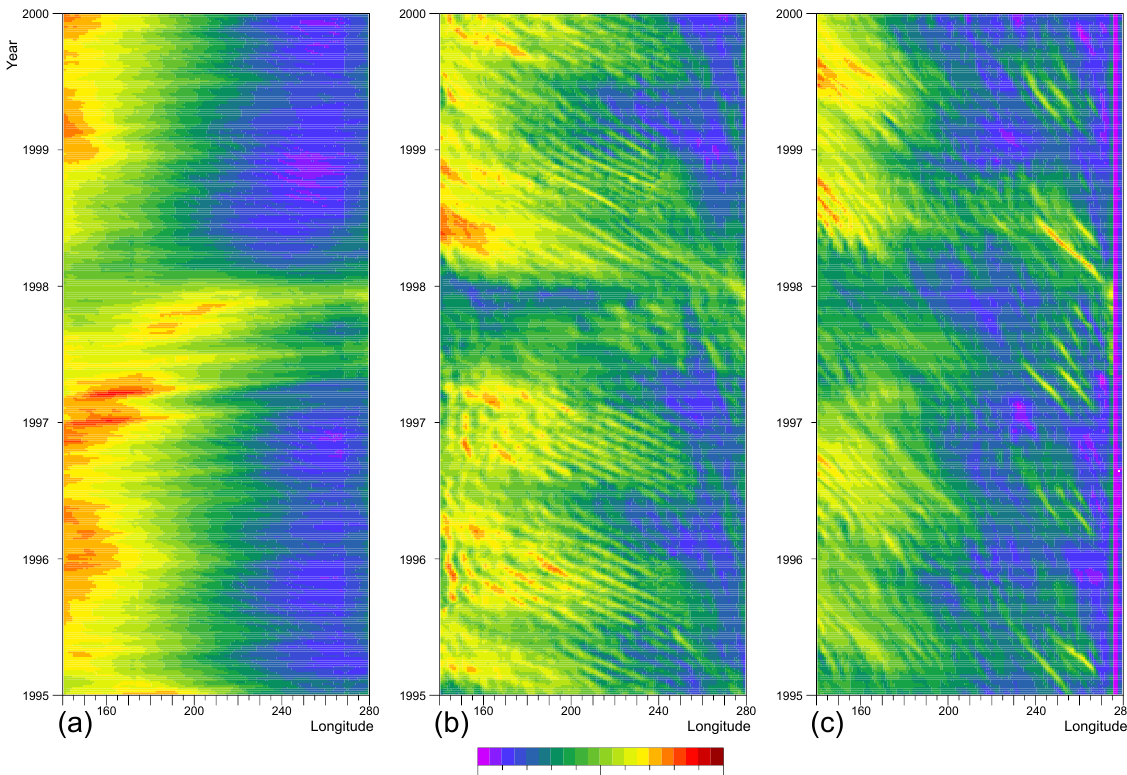
Figure 31. Sea surface height (m) during the period 1995 to 2000 at (a) the Equator, (b) 6 ◦ N and (c) 9 ◦ N.